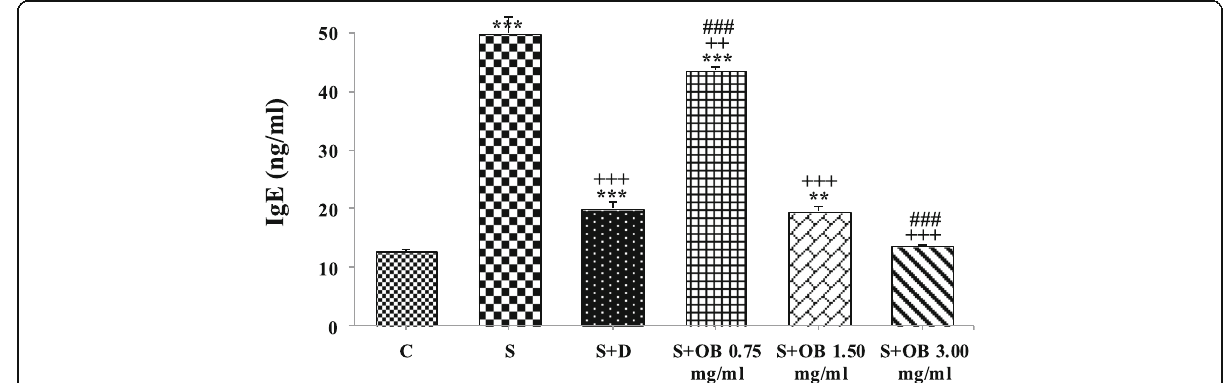
Fig. 4 Bronchoalveolar lavage fluid level of IgE (mean ± SEM) in the control (C), sensitized (S), treated sensitized animals with dexamethasone (S + D) and three O. basilicum concentrations (S + OB) groups, (in each group, n = 8). **: P < 0.01, ***: P < 0.001, comparison with C group. ++: P < 0.01, +++: P < 0.001, comparison with S group. ###: P < 0.001, comparison with S + D group. One-way analysis of variance (ANOVA) with Tukey- Kramer ’ s post-test was used for statistical